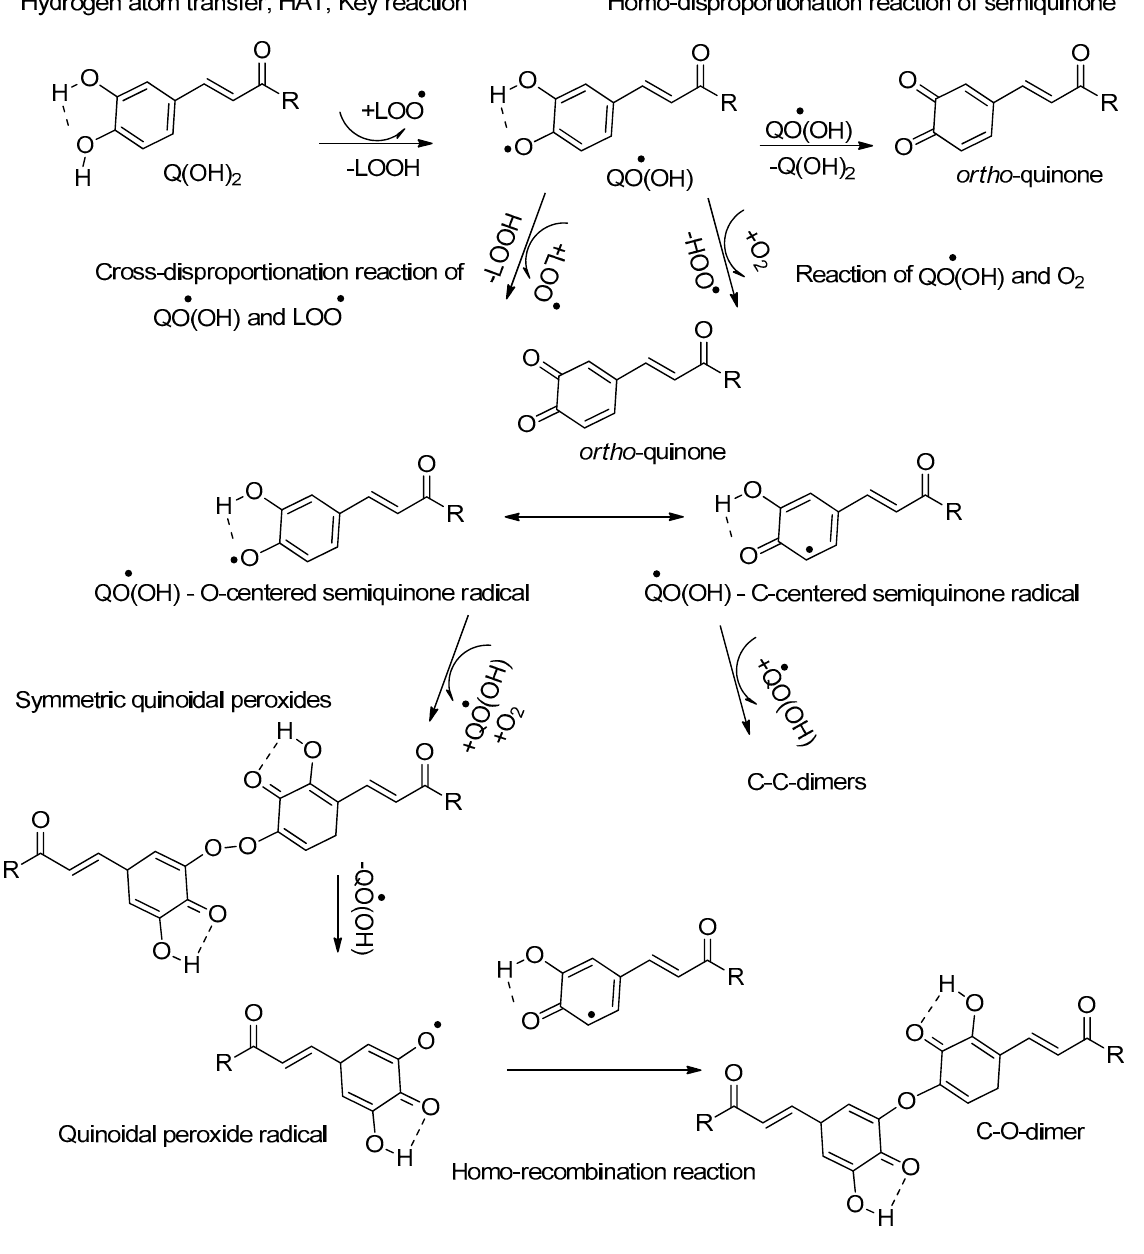
Scheme 4. Reaction mechanism for